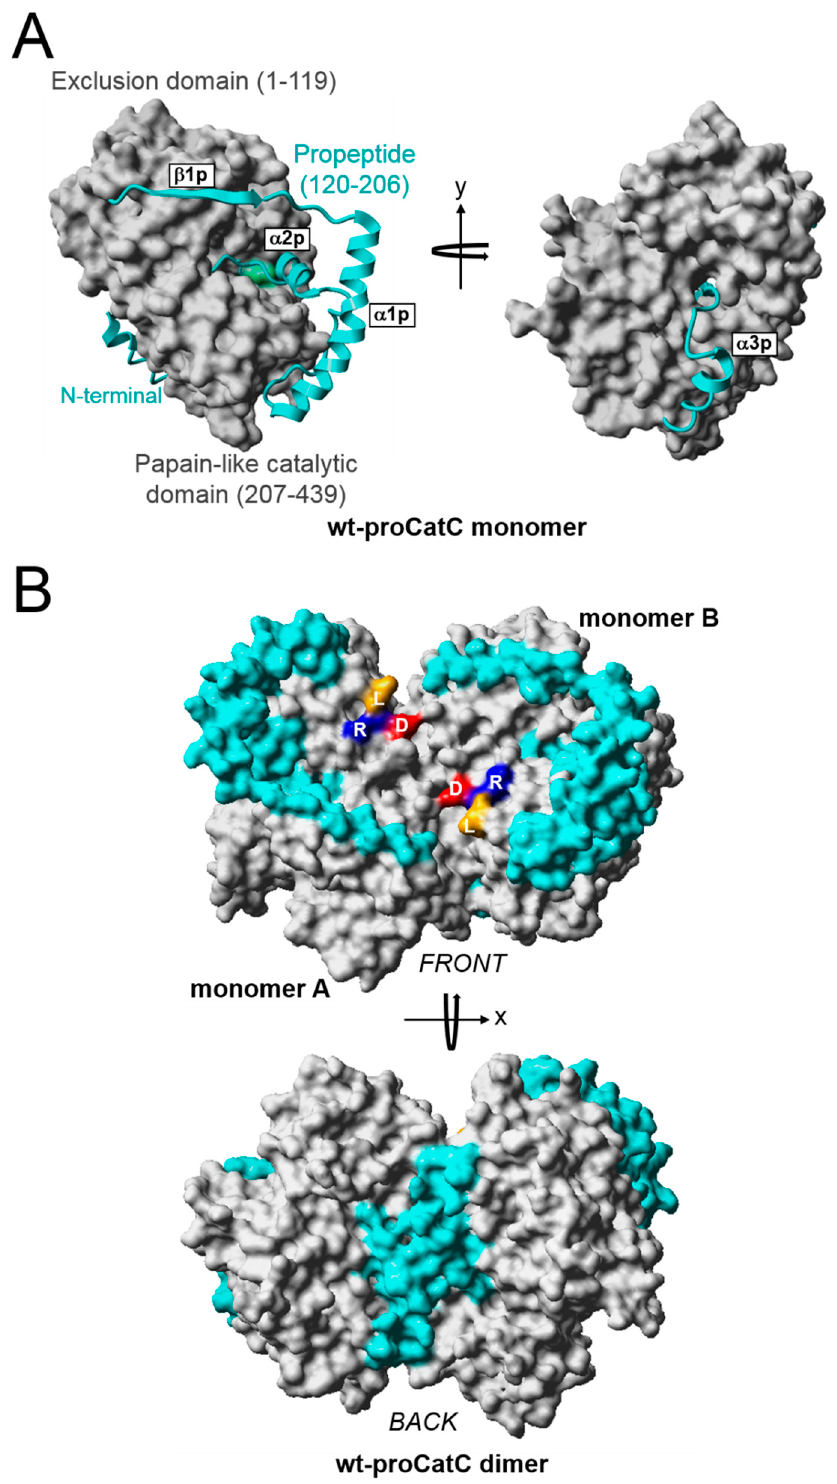
Figure 3. Model structure of wt-proCatC. ( A ) ProCatC monomer. The exclusion domain and papain-like catalytic domain are shown in surface representation and colored in grey. The propeptide (residues Thr120–His206) in the ribbon plot is shown in cyan. The catalytic cysteine 234 is shown in green. ( B ) ProCatC dimer. Monomers A and B are shown in surface representation with the same color coding as in ( A ). Leucine, arginine, and aspartic acid are labeled using their one-letter amino acid codes and shown in dark yellow, blue, and red, respectively. Table 1. Residues localized in monomer interaction interfaces.